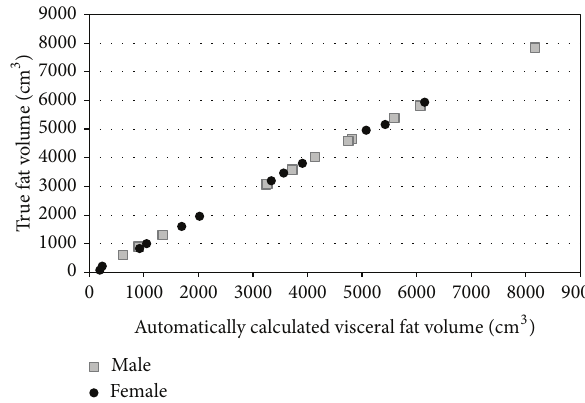
Figure 3: Correlation between automatically calculated visceral fat volumes and true volumes. The correlation coefficient for the female data set is 0.9998 and the coefficient for the male data set is